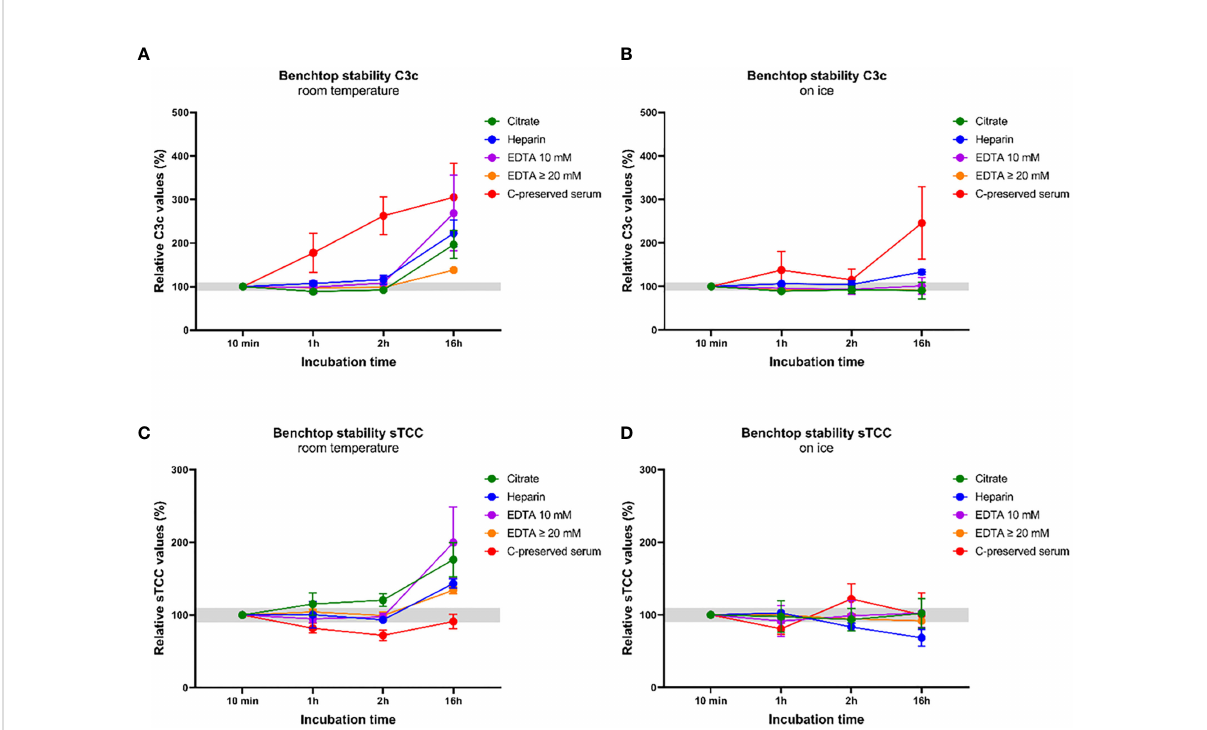
FIGURE 5 Benchtop stability of the components C3c and soluble TCC in serum samples and in plasma samples with different anticoagulants. C3c and sTCC levels were measured in complement-preserved serum samples (n=5) and in plasma samples anticoagulated either with citrate, heparin, EDTA 10 mM and EDTA ≥ 20 mM (n=5 for each anticoagulant). All samples were thawed and incubated at RT or on ice for 10 min, 1h, 2h and 16h before measurements. (A) C3c levels measured after incubation at RT and (B) on ice. (C) sTCC levels measured after incubation at RT and (D) on ice. Samples were analyzed using a serial dilution ranging from 1:50 to 1:400 and data are represented as mean ± SEM. Deviation from baseline ≤ 10% is highlighted in